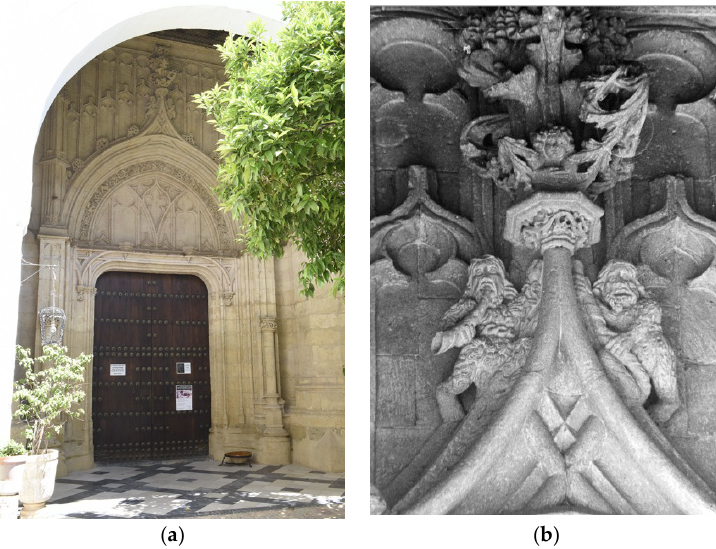
Figure 13. Santa Marta Monastery (Cordoba): ( a ) church portal; ( b ) feature of the high point of the ogee arch . Photos took by